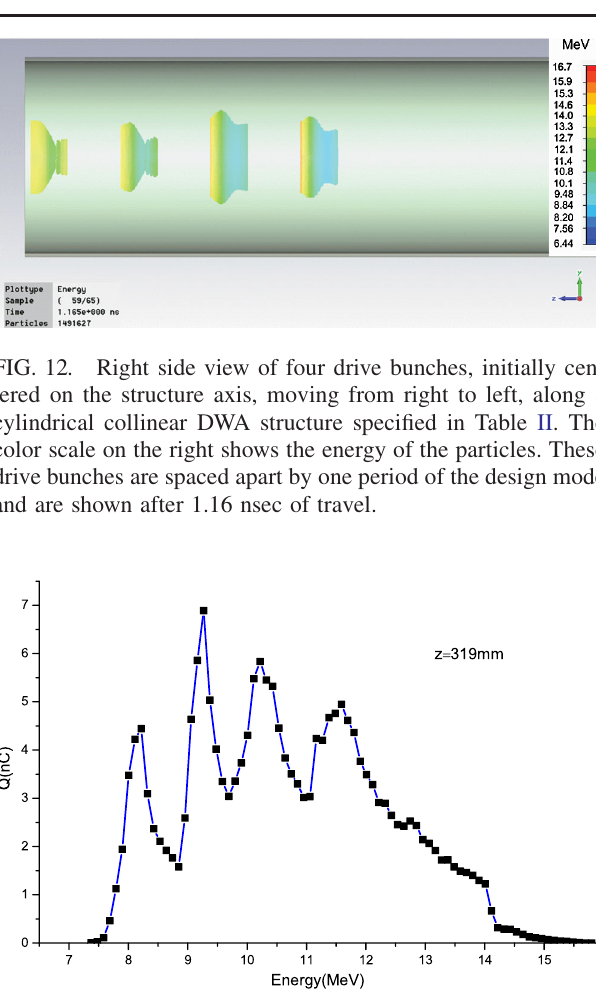
FIG. 13. Distribution function of HBT particles after traveling 319 mm in the cylindrical collinear DWA